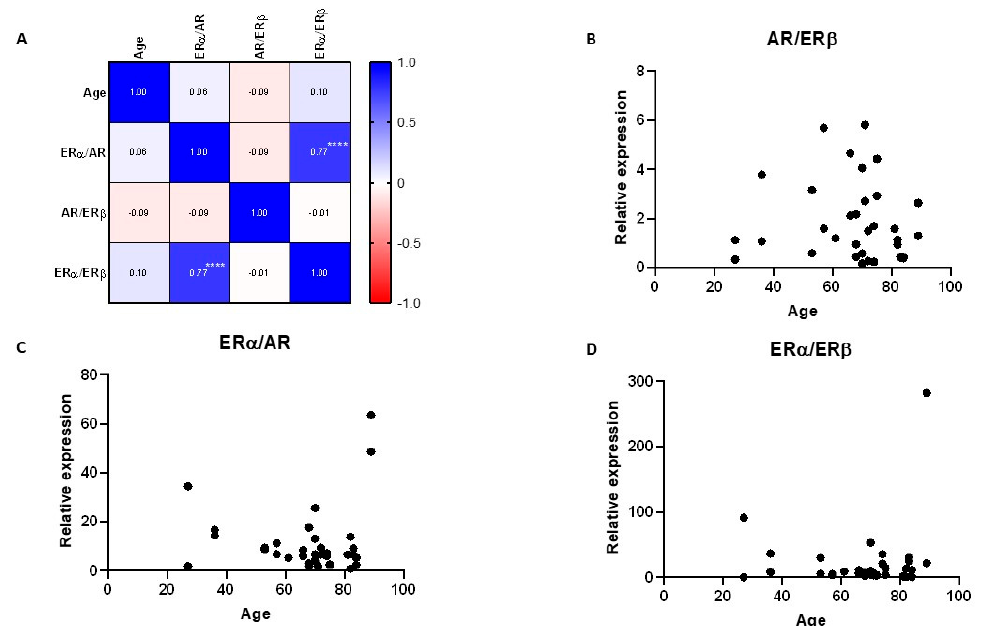
Figure 4. Correlation of sex steroid receptor mRNA expression ratios in human lacrimal glands with age. ( A ) Correlation matrix showing correlation coefficients between age and sex steroid receptor expression ratios; ( B – D ) Scatter plots showing the relationships between age and AR to ER β , ER α to AR, or ER α to ER β ratios. **** p < 0.0001.